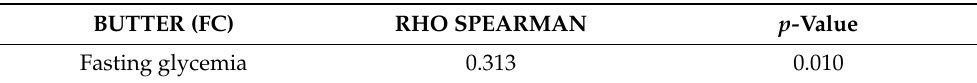
Table A12. Association between higher consumption of butter and greater glucose intolerance in baseline